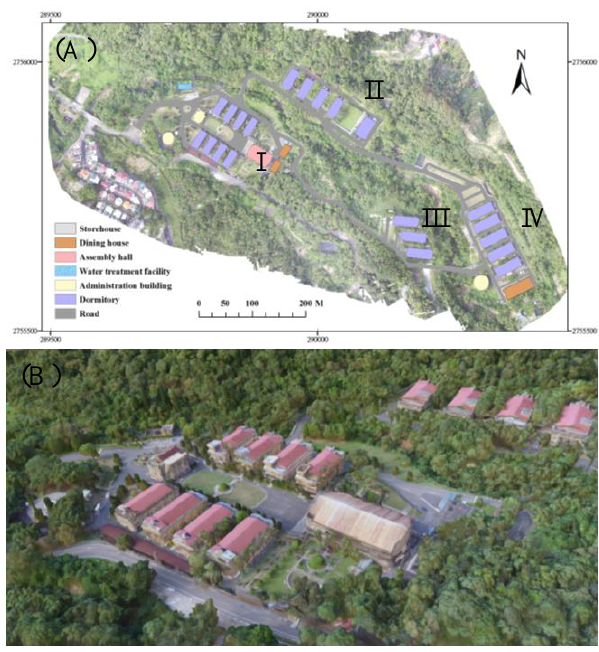
Figure 1. (A)The overview map of the study site (map projection: TWD 97); (B) The 2.5D map of the dormitory area I.